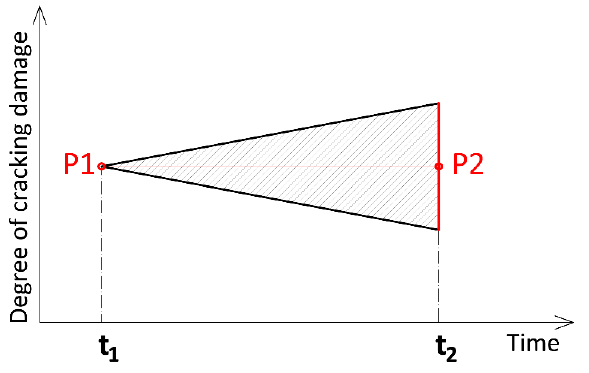
Figure 8. Principles of the TBTC construction. Points P1 and P2 are plotted on the horizontal time axis, point P1 is the vertex of an isosceles triangle and point P2 is the center of its base. The width of the base is not prescribed but should be identical for all compared materials (triangles) in one graph. Only